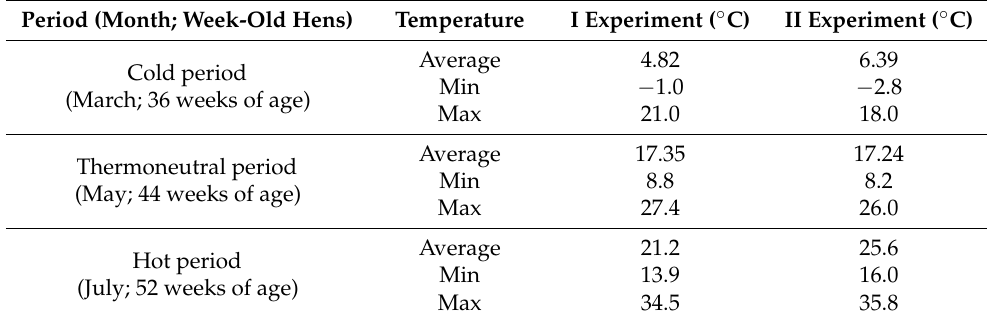
Table 2. Weekly ambient temperatures during blood